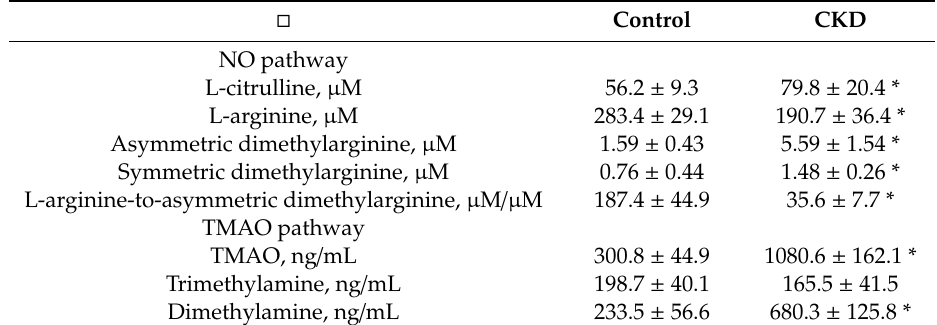
Table 1. Plasma levels of nitric oxide (NO)- and trimethylamine- N -oxide (TMAO)-related parameters in mother rats.